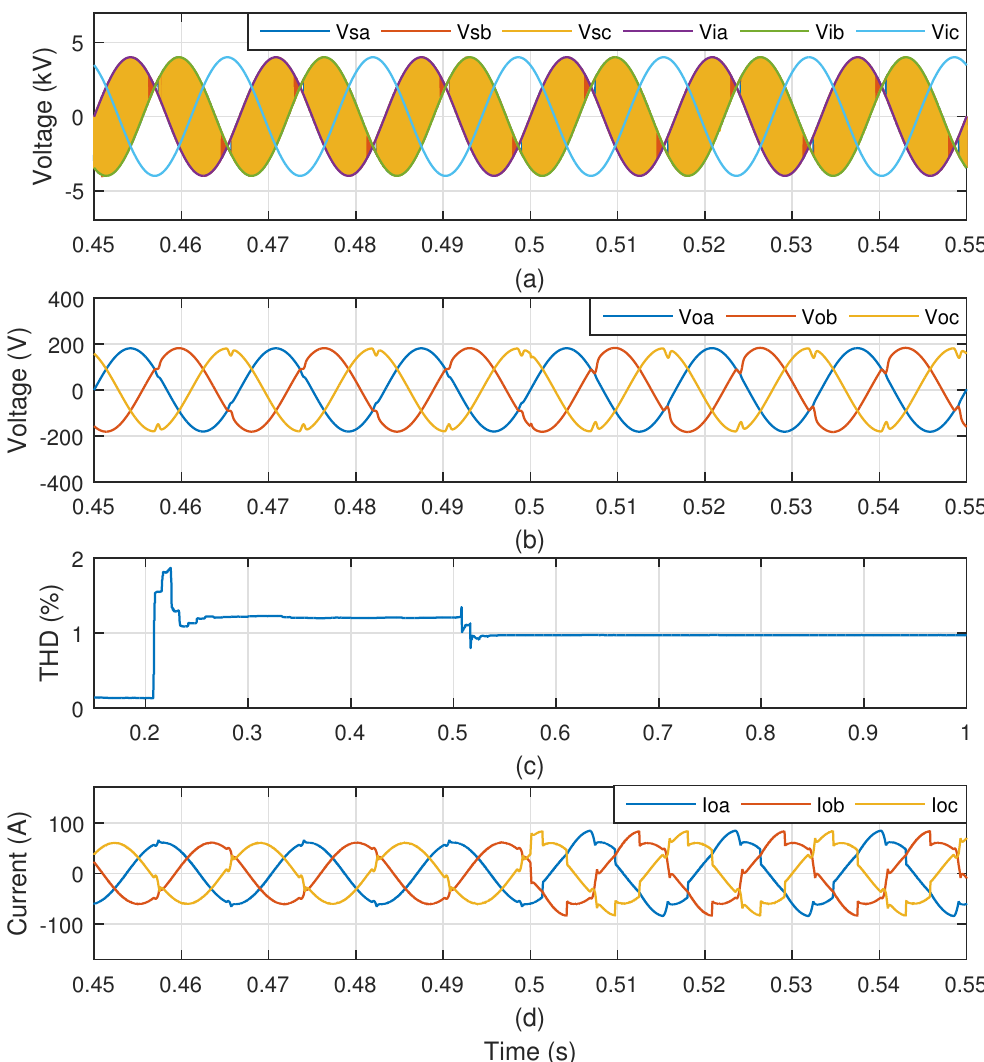
Figure 17. AC-AC 2 × 3 DMC operation with the grid voltage ( v iabc ) balanced and sinusoidal. ( a ) Output switched voltage along with input voltage, ( b ) output voltage, ( c ) output voltage THD, and ( d ) output